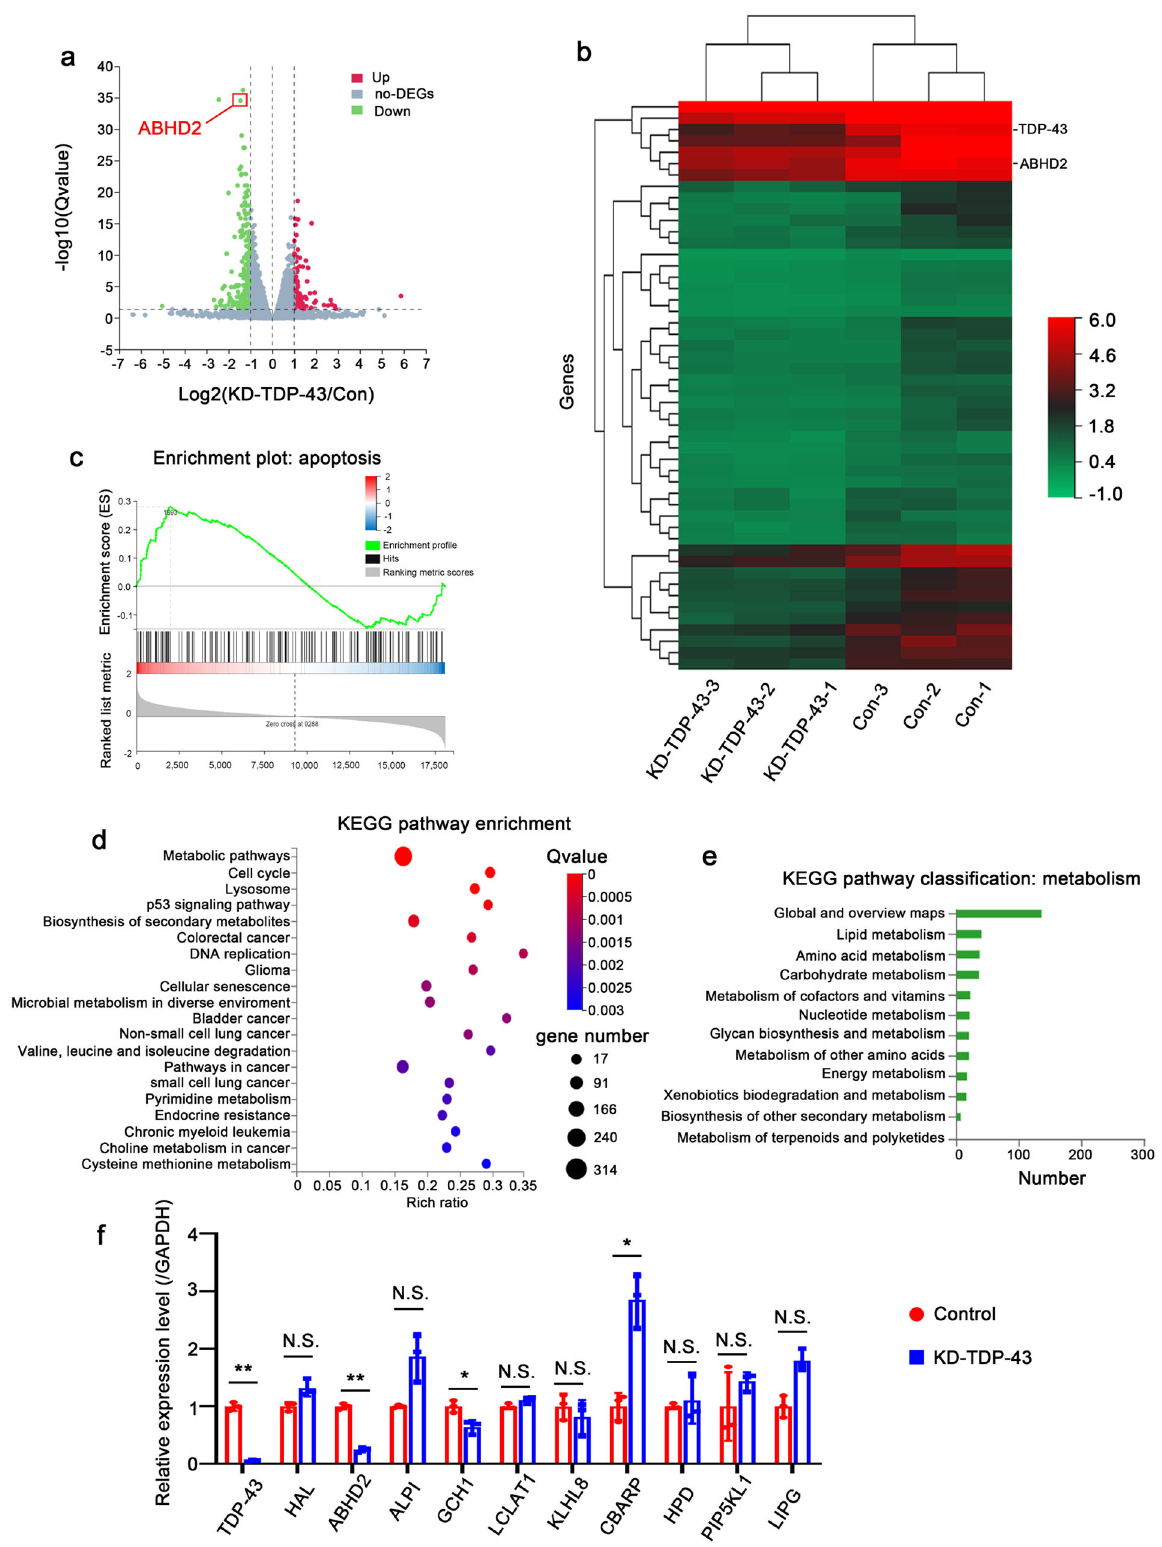
effect of TDP-43 was mediated through ABHD2-associated lipid metabolism, we next evaluated the role of the metabolite FFA in TDP-43-inhibited apoptosis. We performed rescue experiments by FFA in SMMC-7721 cells with knockdown of TDP-43. Flow cytometry, qRT-PCR and Western blot assays showed that FFA treatment effectively reversed the apoptosis caused by